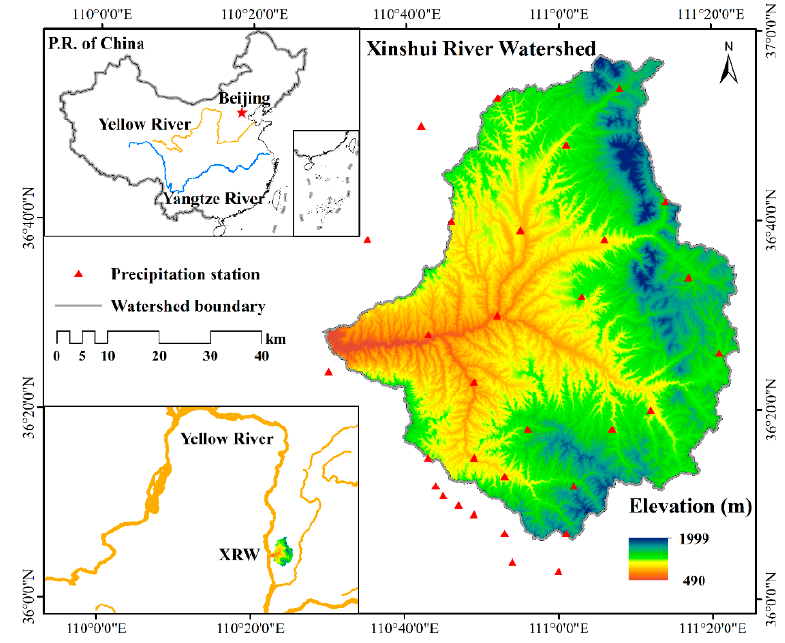
Figure 1. Location of the Xinshui River watershed and spatial distributions of precipitation station.